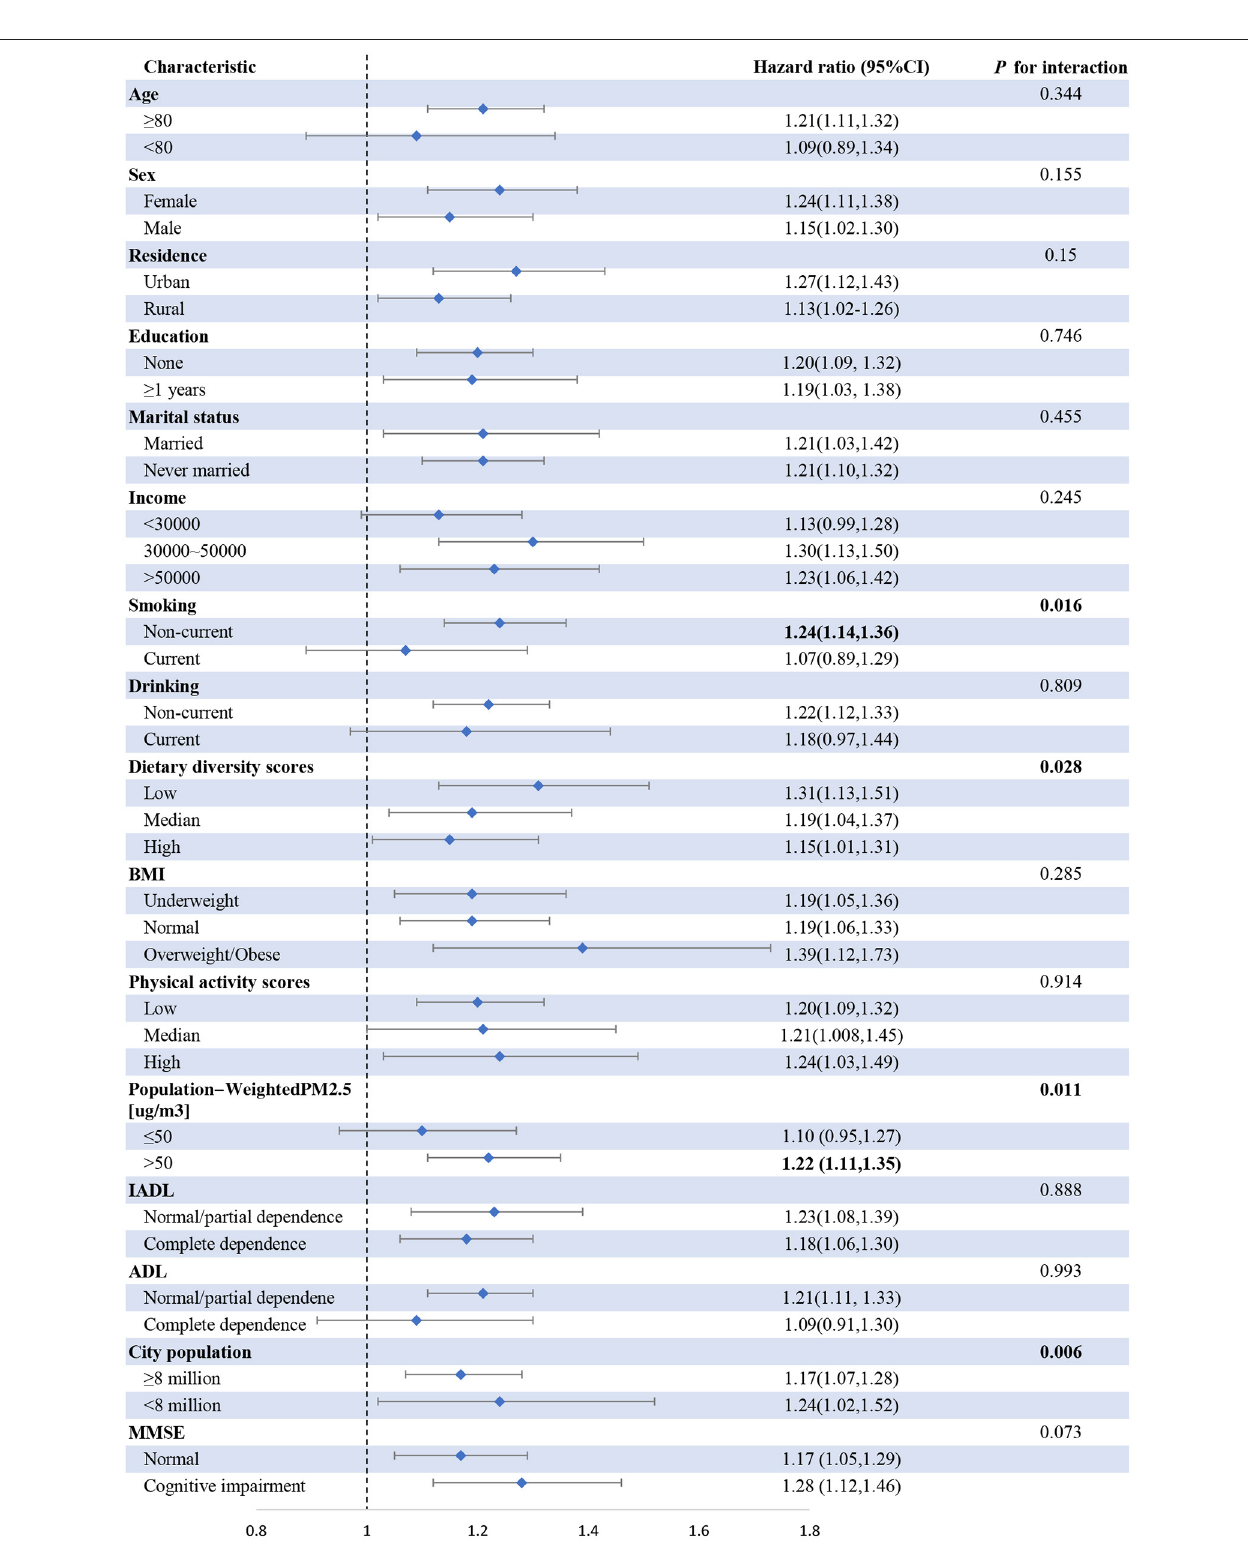
FIGURE 2 | Association of cooking fuel use with mortality among subgroups. Adjustment: sex, age, residence, alcohol drinking, dietary diversity score, BMI, marital status, social activity, education, income and city population, IADL, ADL, MMSE, and chronic disease.